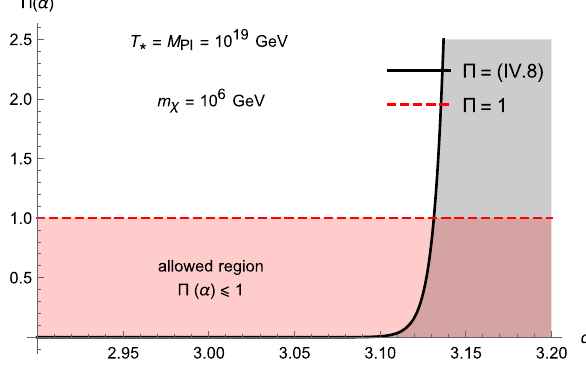
Fig. 1 (cid:24)(α) vs α . The plot shows the allowed region corresponding to (cid:24)(α) ≤ 1, where the value (cid:24) (cid:13) 1 corresponds to the observed value (cid:23) 2 (cid:13) 0 , 1188 (see Eq. DM h